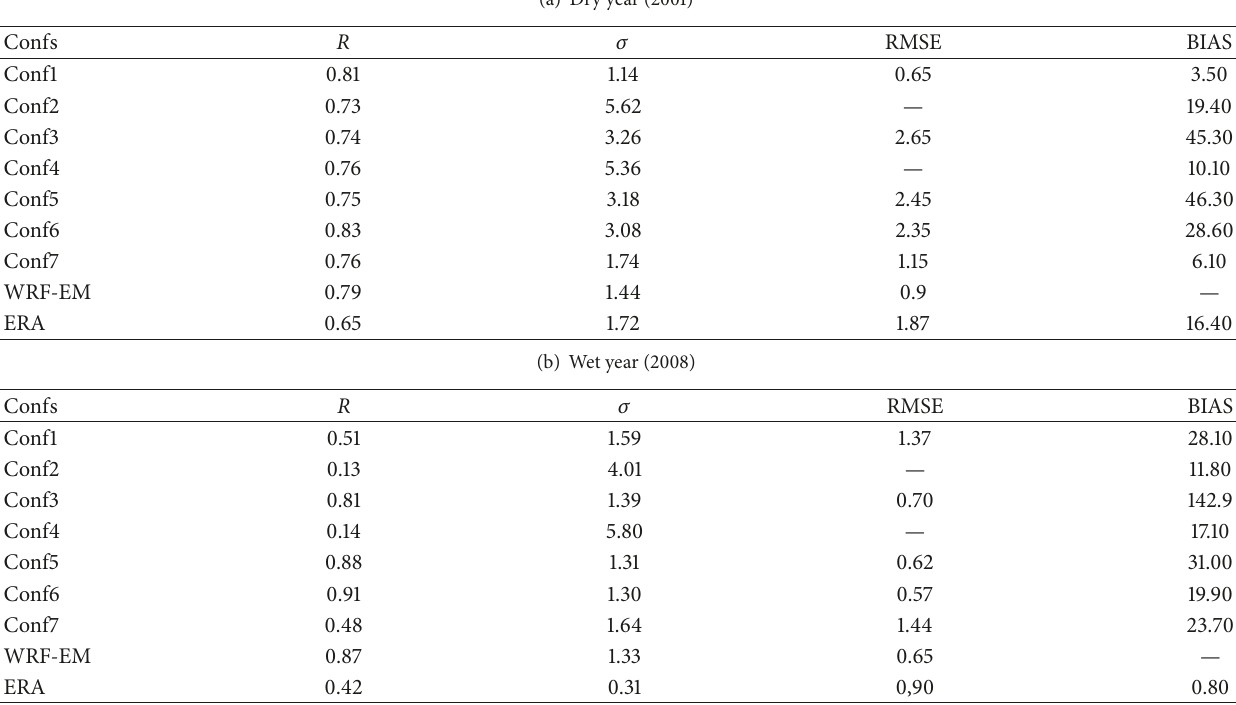
Table 5: The four different statistics, for the forest zone, (a) for the dry year and (b) for the wet year.